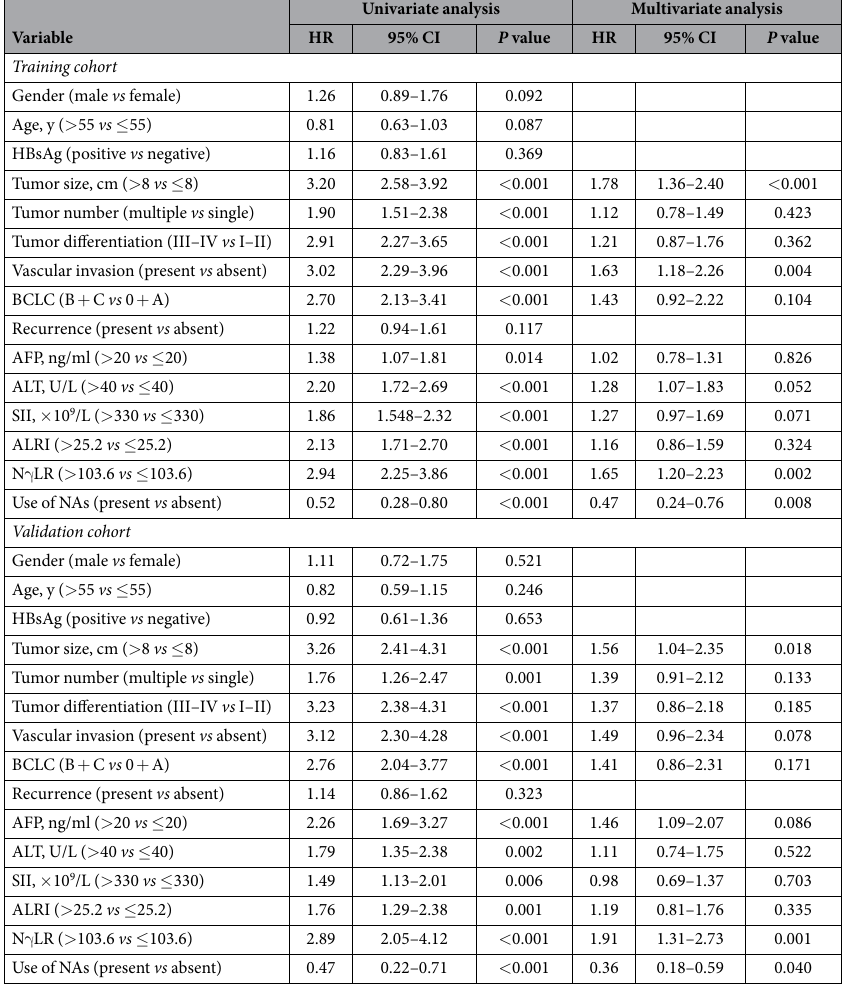
Table 3. Analysis of overall survival in HCC patients in the training and validation cohort. HBsAg, hepatitis B surface antigen; BCLC, barcelona-clinic liver cancer; AFP, alpha-fetoprotein; ALT, alanine